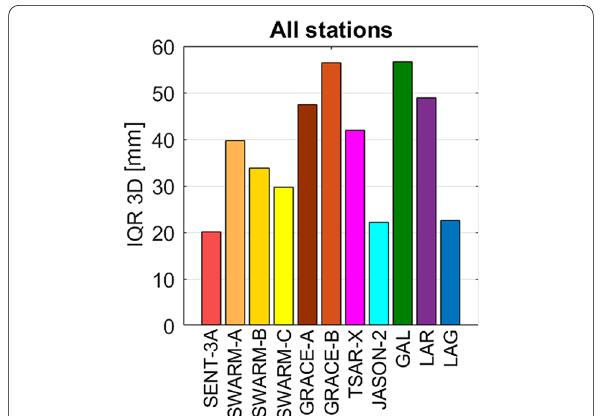
Fig. 7 Repeatability of estimated station coordinates by the means of IQR for LAGEOS, LARES, particular LEO satellite, and Galileo constellation (pre-analysis results)